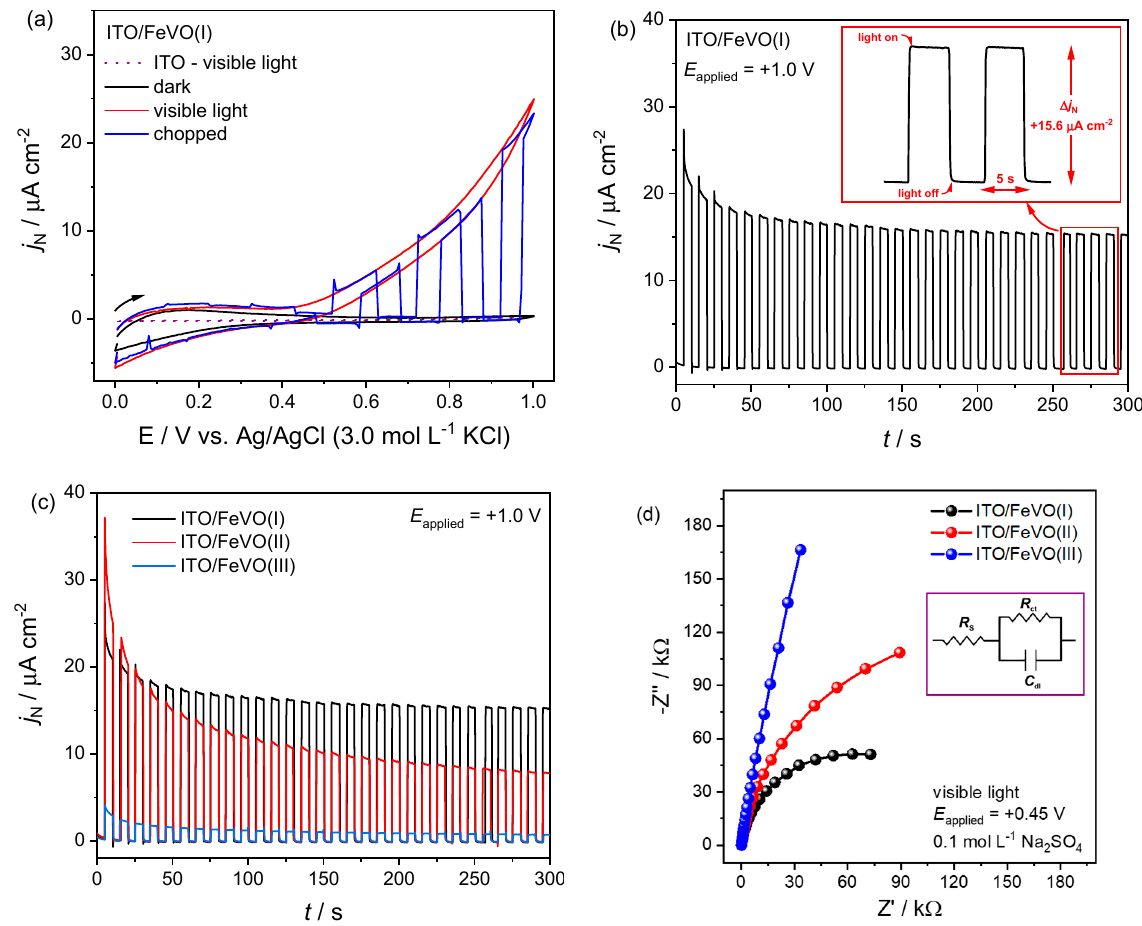
Figure 3. Photoelectrochemical measurements for the ITO/FeVO electrodes using cyclic voltammetry in the dark (solid black line), under continuous light illumination (solid red line), and under transient (chopped) light illumination (solid blue line) (10 s on/off) conditions. Scan rate of 10 mV s − 1 ( a ). Photochronoamperogram under chopped light illumination (5 s on/off), at a +1.0 V (vs. Ag/AgCl), for ITO/FeVO(I) electrode ( b ), and for ITO/FeVO(I) -(II) and -(III) electrodes ( c ). Nyquist plot (electrochemical impedance spectroscopy), for the ITO/FeVO electrodes under visible light condition, at +0.45 V (vs. Ag/AgCl) ( d ). All measurements were performed in 0.1 mol L − 1 Na 2 SO 4 aqueous solution (pH = 5.4). Inset in ( b ), amperogram response under chopped light condition, and ( d ) simple Randles model circuit.